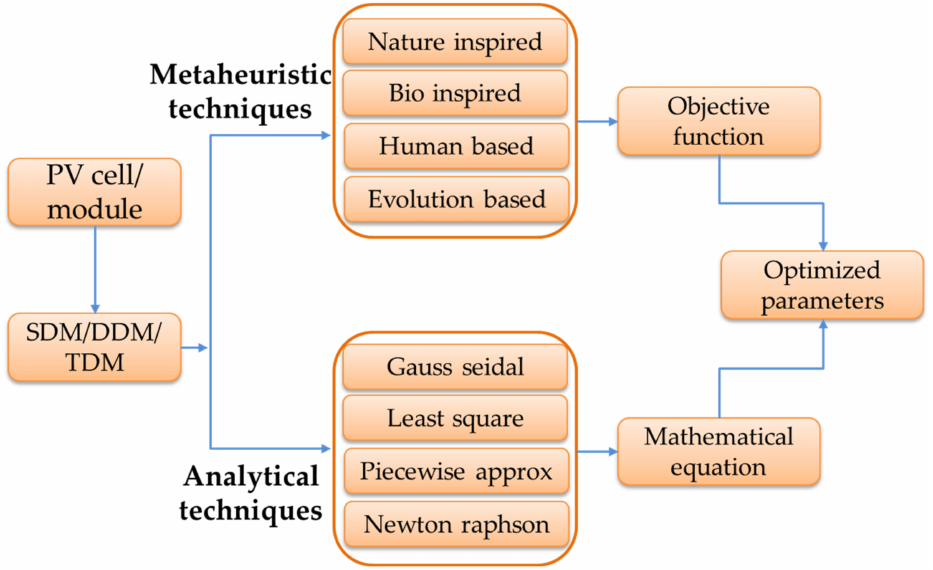
Figure 3. Different processes for modeling and parameter estimation of PV cells. PV: photovoltaic, SDM: single-diode model, DDM: double-diode model, and TDM: triple-diode model (adapted with permission from Ref. [13]. Copyright 2022 John Wiley and Sons).